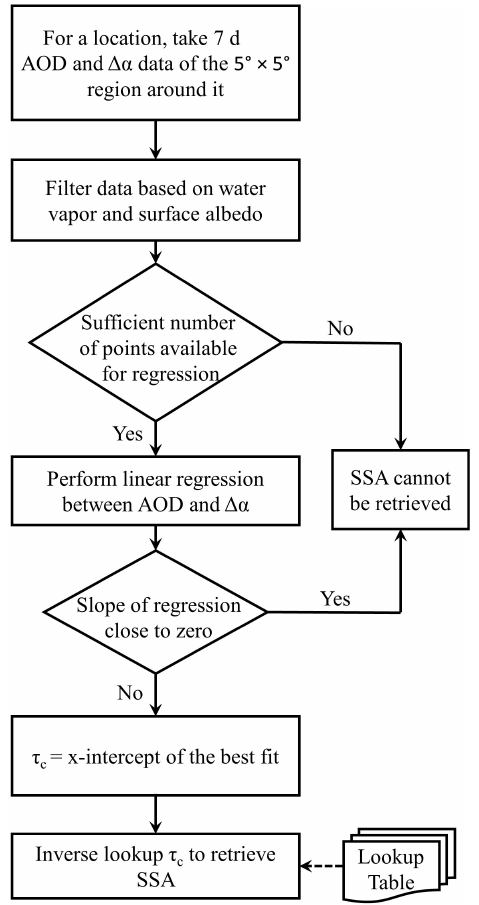
Figure 2. Flowchart depicting the steps involved in combined CERES-MODIS retrieval of SSA for a particular